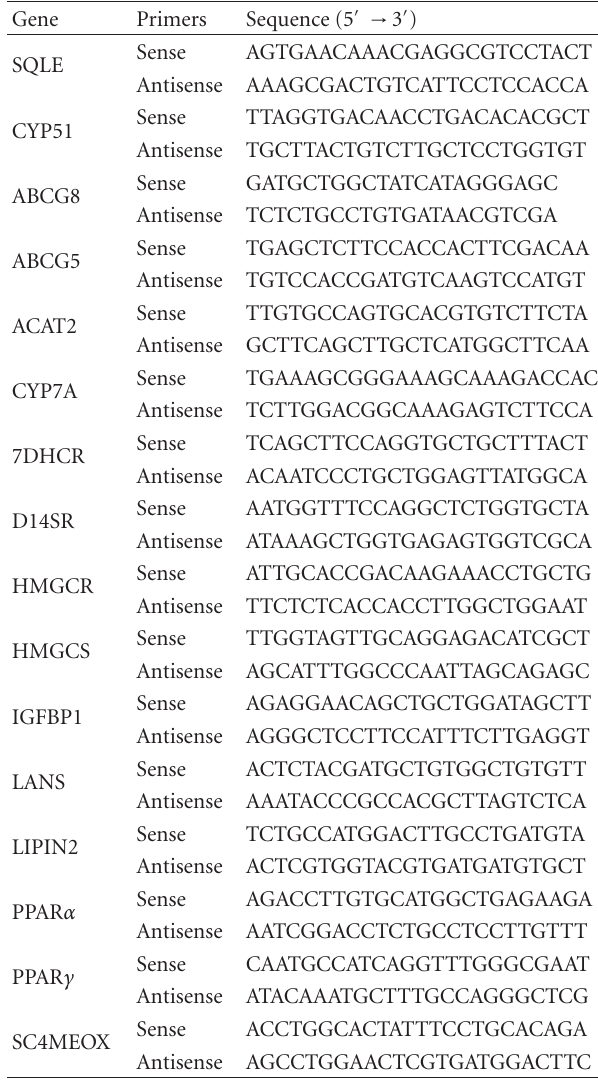
Table 1: Oligonucleotide sequences used for RT-PCR analysis. Gene